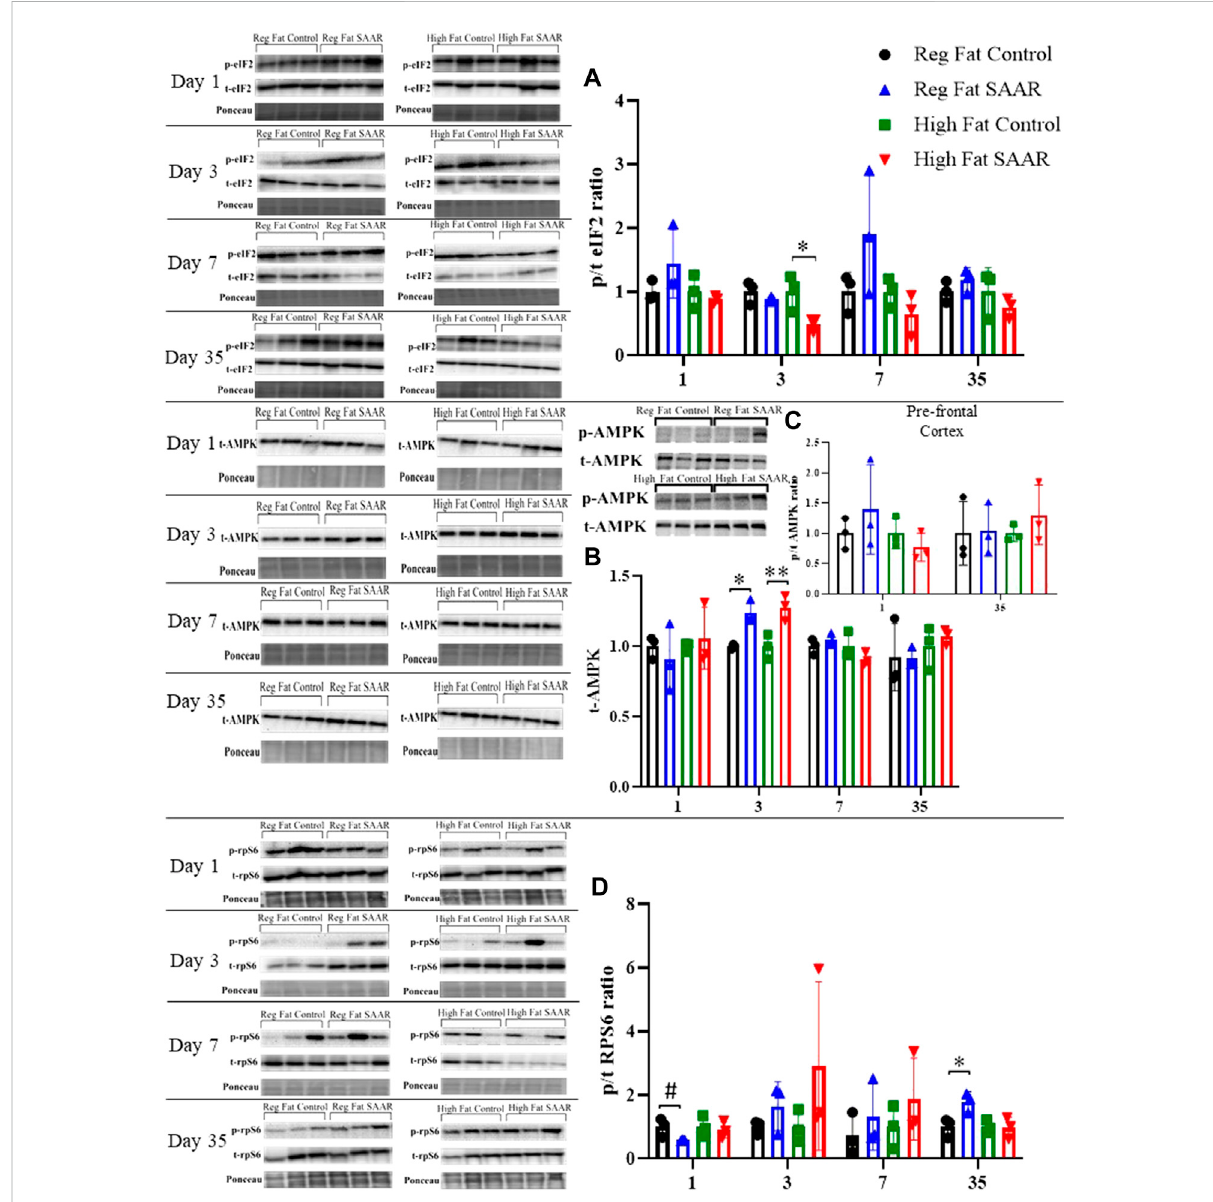
FIGURE 3 Immunoblot data for eIF2, AMPK, and rpS6 at days 1, 3, 7, and 35 of whole-brain homogenates. Phosphorylated (p) and total (t) proteins were detected and expressed as p/t ratios to re fl ect activation of proteins. Ponceau staining was used to normalize for total protein loading. (A) At day 3, micefedaHighFatSAARdiethadsigni fi cantlylowereIF2activationcomparedtocontrol. (B) PhosphorylatedAMPKwasundetectableinwhole-brain homogenate;onlyt-AMPKisanalyzed. Atday3,boththeRegularFatSAARandHighFatSAARgroupshadgreatert-AMPKcontentthancontrol. (C) Phosphorylated AMPK was detectable in pre-frontal cortex. Due to limited pre-frontal cortex tissue, only p/t ratios for day 1 and day 35 were assessed and no differences were observed. (D) rpS6 activation tended to be lower in the Regular Fat SAAR group at day 1, however, at day 35 was signi fi cantly greater than control. Data are presented as mean ± SD ( n = 3/group). eIF2, eukaryotic initiation factor 2; AMPK; AMP-activated protein kinase; rpS6, ribosomal protein S6. * p < 0.05, ** p < 0.01, # 0.05 < p < 0.10. SAAR diets are compared to their respective SAA suf fi cient control